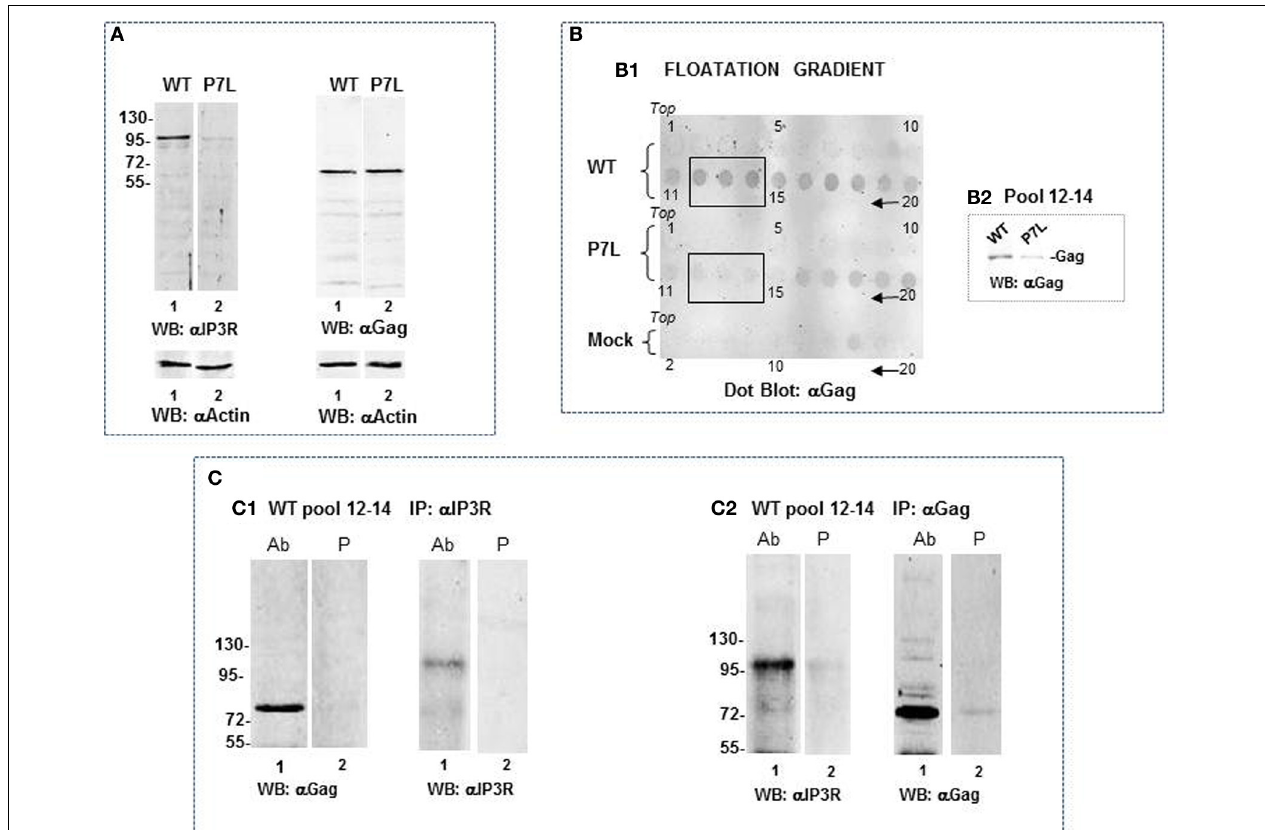
FIGURE 8 | Differential association of IP3R with WT-Gag and P7L-Gag. (A) Western analysis of P2 fraction prepared from cells transfected with DNA encoding WT Gag or P7L-Gag. IP3R probing shows ∼ 100kDa IP3R-related fragment as predominant species detected by antibody. Gag probing shows equivalent amounts of wild-type and mutant Gag in P2 fraction. (B) Floatation on sucrose density gradient of P2 fraction prepared from cells that had been transfected with DNA encoding WT Gag ( top ), transfected with P7L-Gag ( middle ), or mock-transfected ( bottom ). Fraction 1 is the top of the gradient.